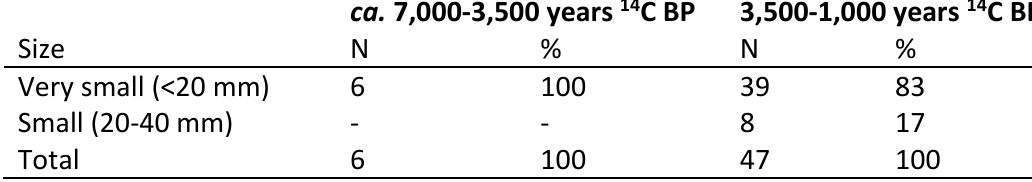
Table 6. Size of complete flakes by period.